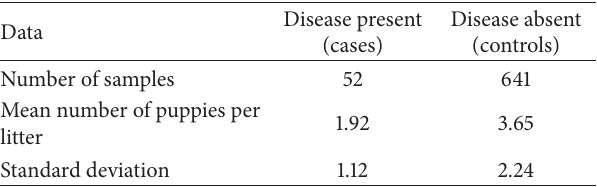
Table 4: Number of puppies per litter with presence or absence of